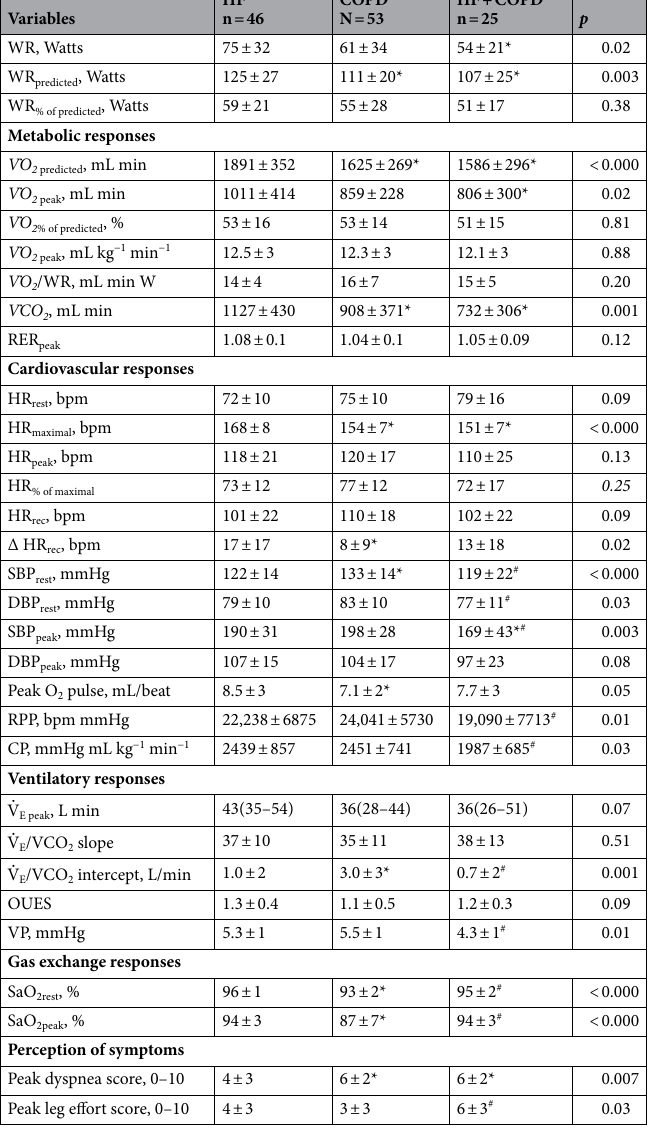
Table 2. Comparison between group responses to incremental CPET. Used ANOVA one way for continuous variables and used chi-square test for categorical variables. HF heart failure, COPD chronic obstructive pulmonary disease, M male, F female, BMI body mass index, LV left ventricle, LA left atrium, RVD right ventricle diameter,